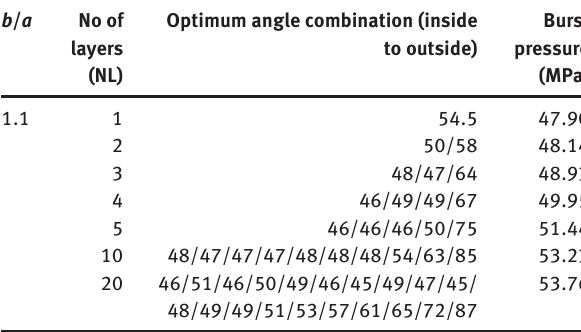
Table 1: Optimum ply angles and the maximum burst pressure obtained using the genetic